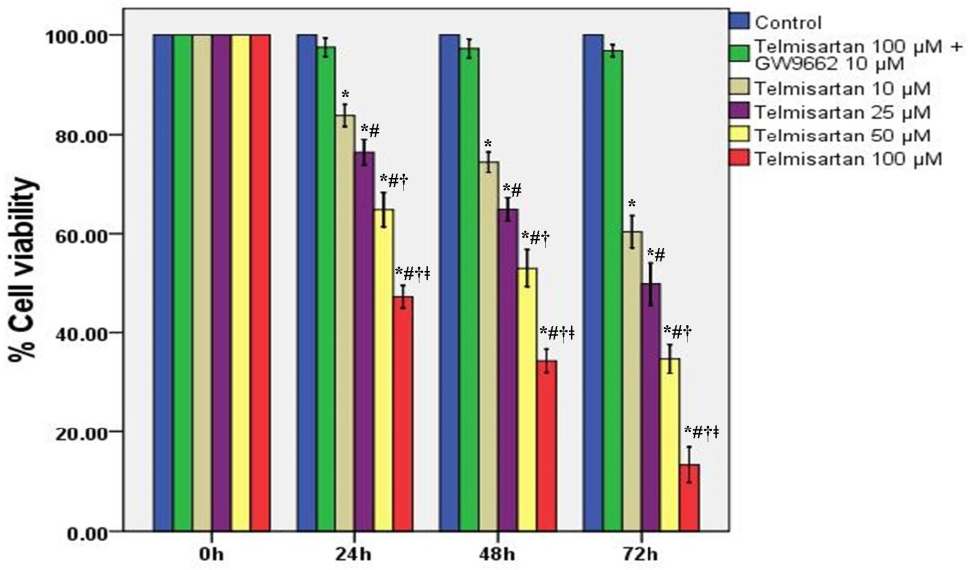
Figure 2. Telmisartan reduces the cell viability of A549 cells. The cell viability of A549 cells was analyzed by trypan blue exclusion assay at specific time points (0, 24, 48, and 72 h) with 4 different concentrations of telmisartan (10, 25, 50 and 100 μ M) or GW9662 (10 μ M). Quantitative data are presented as mean ± SD ( n = 4). * p < 0.05 compared with Control at the corresponding time points. # p < 0.05 compared with 10 μ M telmisartan at the corresponding time points. † p < 0.05 compared with 25 μ M telmisartan at the corresponding time points. ǂ p < 0.05 compared with 50 μ M telmisartan at the corresponding time